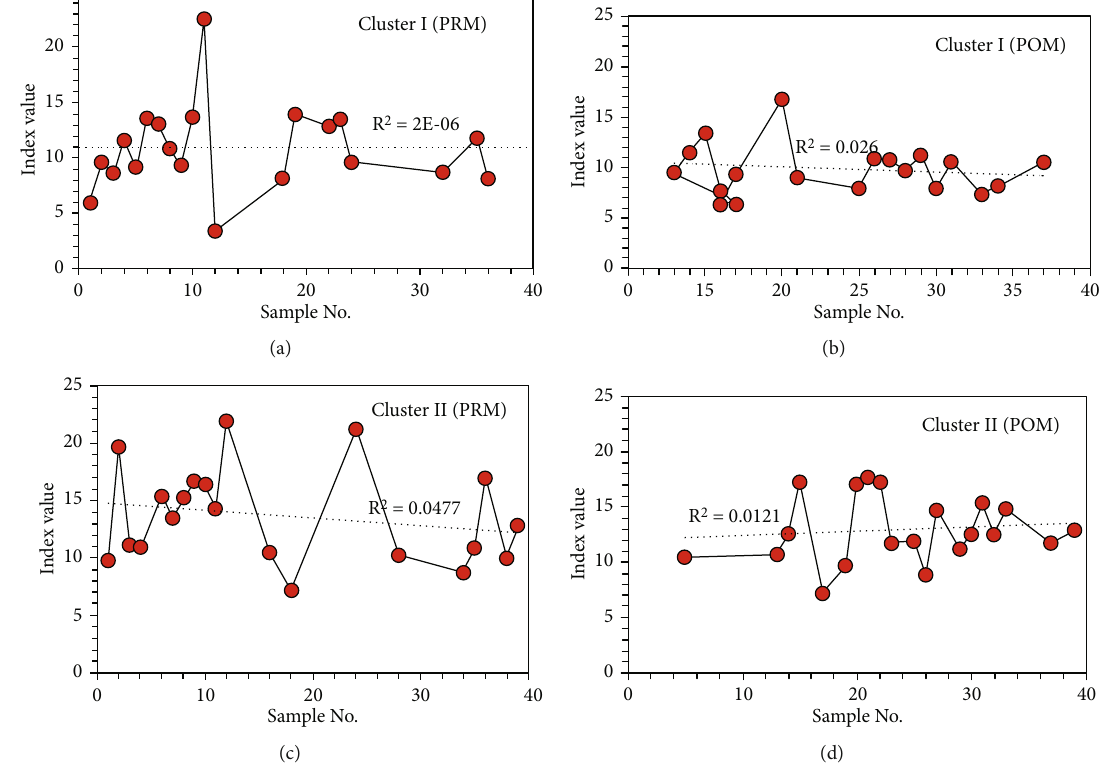
Figure 9: Bivariate plots of sample no. vs. bicarbonate index (BCI) value of each cluster.